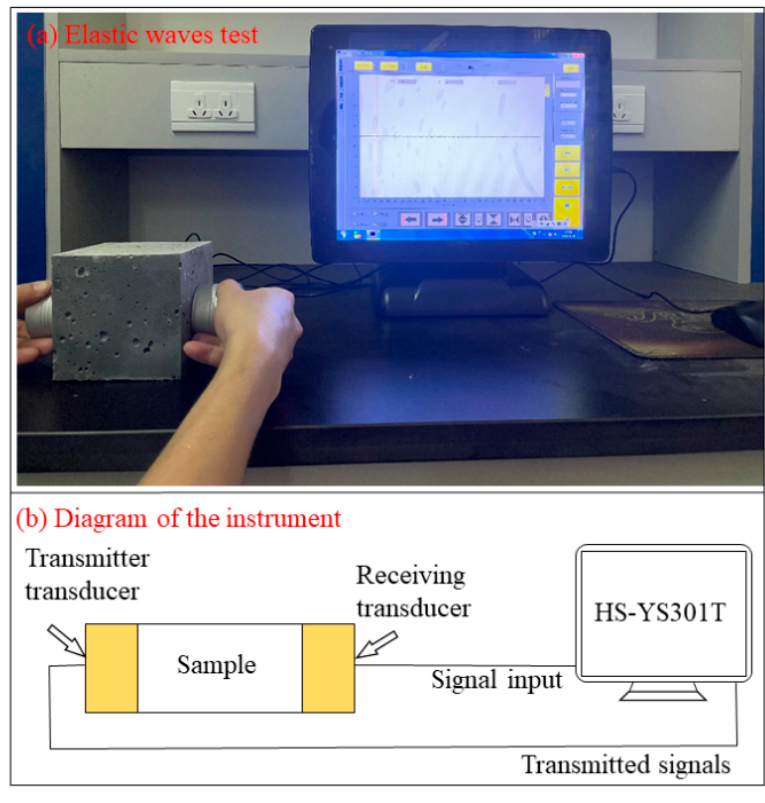
Figure 2. The photo ( a ) and diagram ( b ) of elastic wave test